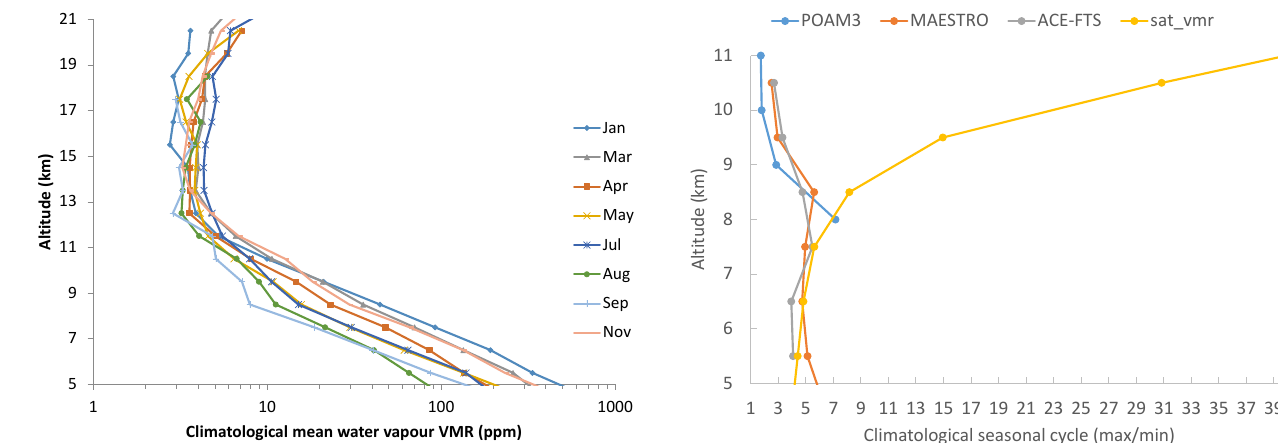
Figure 5. Vertical profile of the seasonal cycle amplitude of Antarc- tic water vapour observed by three instruments. The amplitude is calculated by taking the ratio of climatological monthly means at maximum (January or December) and minimum (August or September). Note that POAM III has a different orbit that tends to sample consistently at higher latitudes (Nedoluha et al., 2002) and thus tends to have stronger seasonality at 8km (driven by the larger temperature range). The saturation vapour pressure climatology is obtained using GEM analysis temperatures sampled at ACE mea- surement